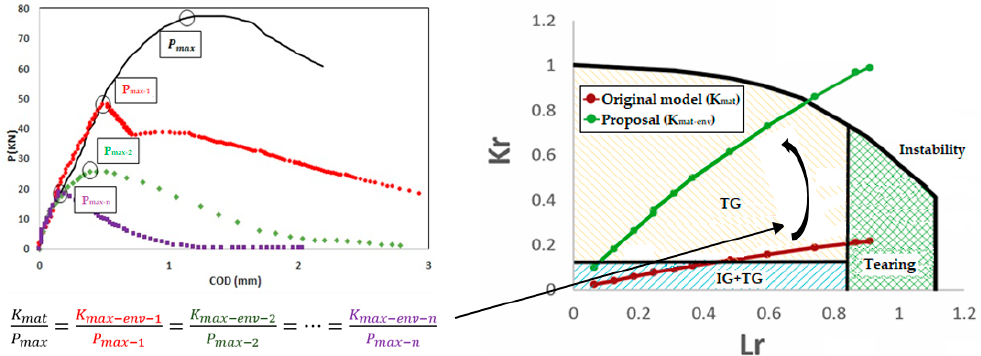
Metals 2019 , 9 , x FOR PEER REVIEW Figure10. Proposalforthedefinitionofthecrackpropagationinitiationbasedontheelastic-plasticrange. Figure 10. Proposal for the definition of the crack propagation initiation based on the elastic-plastic range.